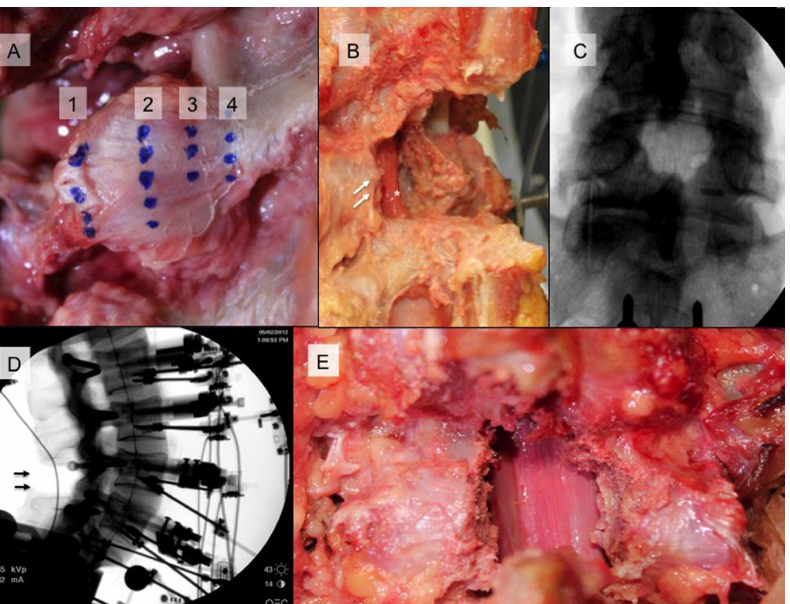
Figure 3. Capsular facet fibers were marked in each specimen by two observers. As shown in A, Line 1 and 4 correspond to the lateral and medial facet extent with line 2 the midpoint and 3 at 25% distance from midline. An oblique view in B, shows ‘‘traditional open L4/L5 decompression with extent of facet removal (double arrows) and dural decompression (*) shown). AP and lateral radiographs of this decompression are in C and D. Image E represents ‘‘wide factectomy’’ of 40% bilateral medial facet removal.